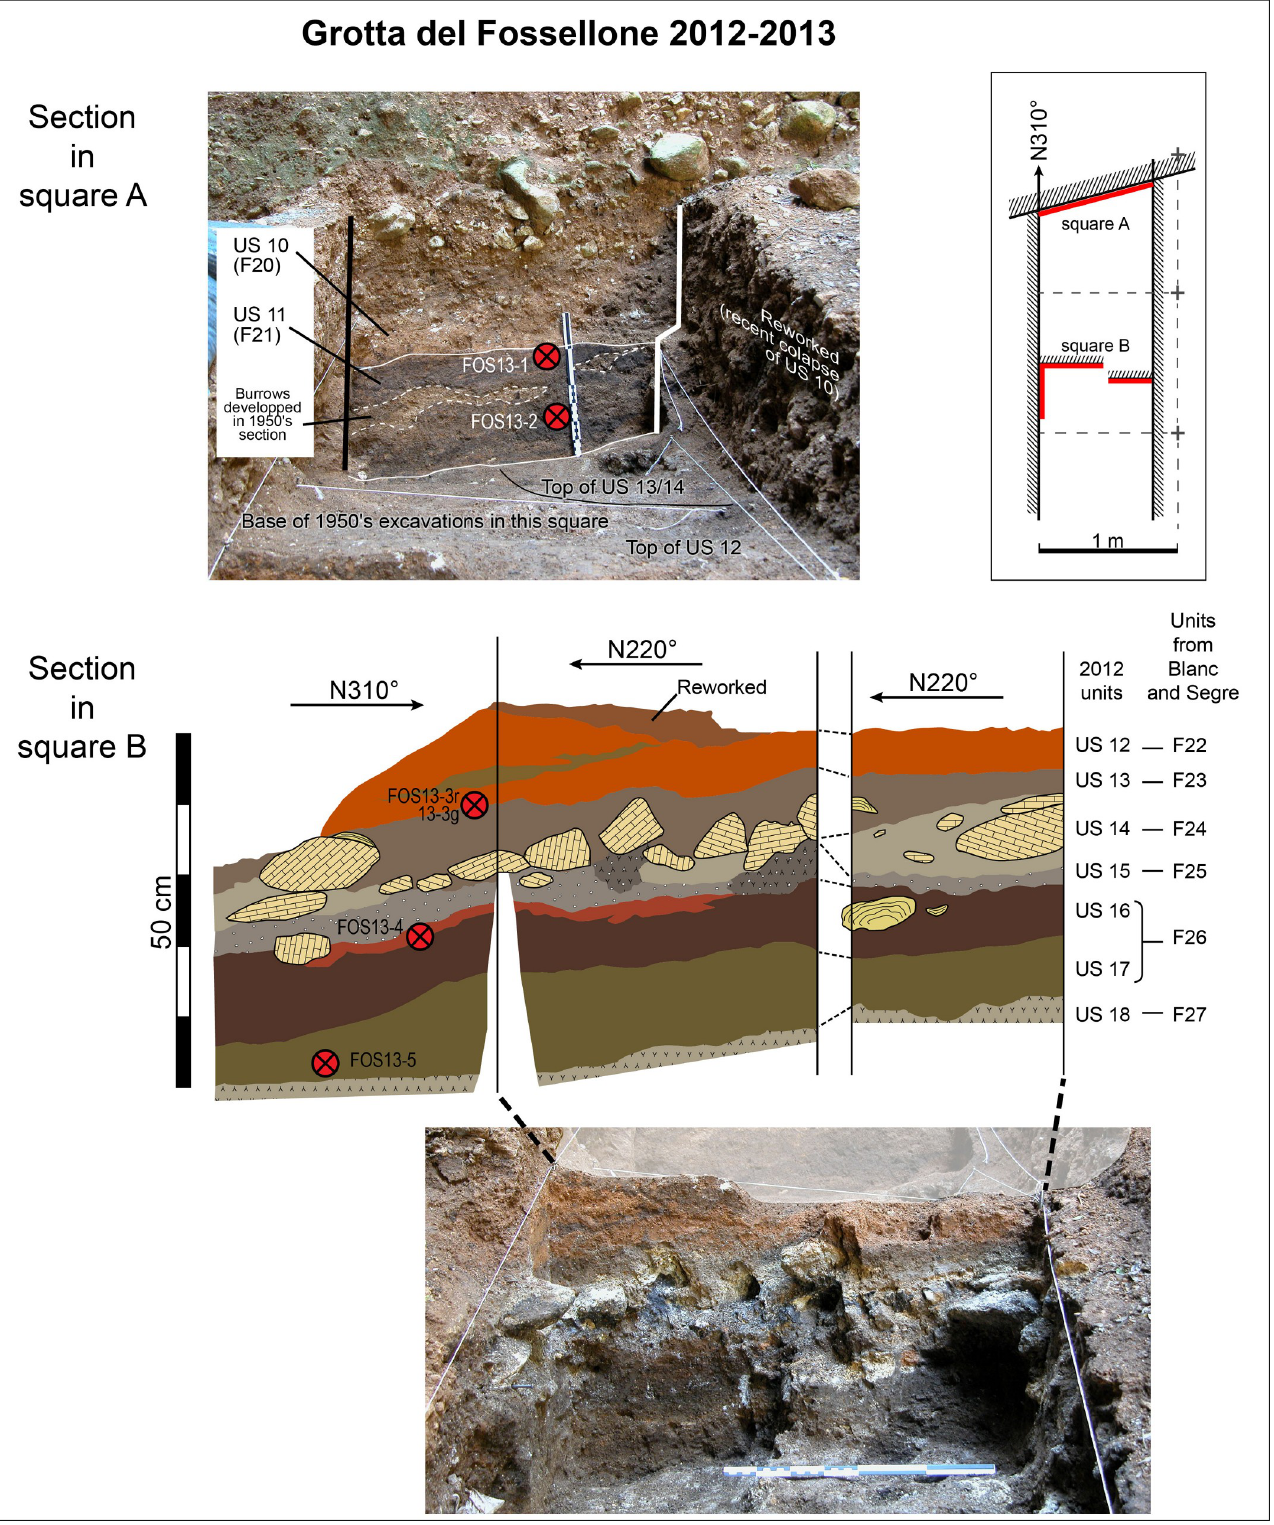
Fig 3. Grotta del Fossellone. Position of samples for luminescence dating in relation to the stratigraphic units defined in 2012.